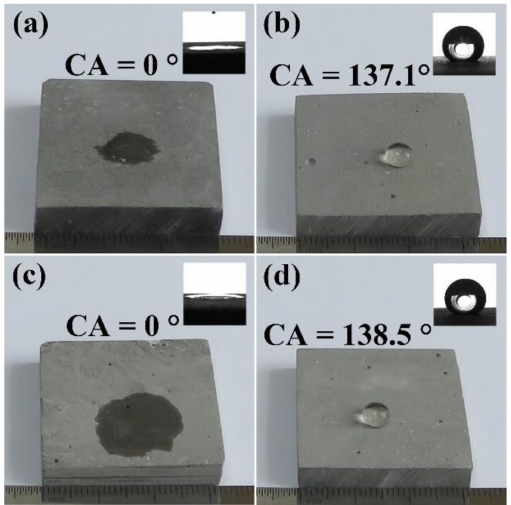
Figure 3. Photos of water droplets on the surfaces of di ff erent HCPs: ( a ) pure HCP; ( b ) 1.0 wt.% SL-modified HCP; ( c ) 1.0 wt.% NS-modified HCP; ( d ) 1.0 wt.% SL and 1.0 wt.% NS co-modified